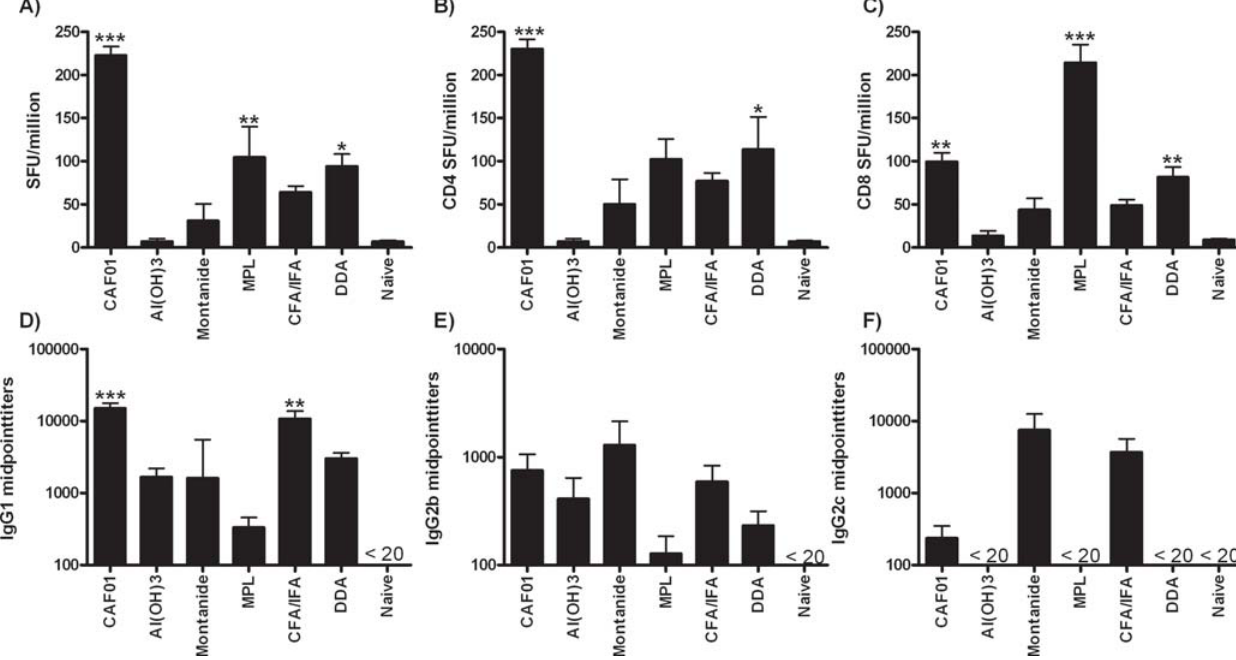
Figure 2. Comparison of CAF01 with other adjuvants. C57BL/6 mice (n=4) were immunized three times with 100 m g of OVA in CAF01, Al(OH)3, Montanide, MPL, CFA/2 6 IFA boosting with a two-week interval. A) Three weeks after the last immunization, the number of OVA-specific cells was assessed by IFN- c ELISPOT. Mean spot-forming units (SFU) upon stimulation with 5 m g of OVA per million cells 6 SEM for each group is shown. B) SFU per million cells 6 SEM upon stimulation with 5 m g of OVA CD4 T cell epitope. C) SFU per million cells 6 SEM upon stimulation with 5 m g of OVA CD4 T cell epitope. D) Sera were analysed for the presence of OVA-specific IgG1, E) IgG2b, F) IgG2c antibodies by ELISA. Mean EC50 6 SEM is shown. Values marked with an asterisk are significantly different (*, p , 0.05; **, p , 0.01, p , 0.001) compared to naı¨ve controls as assessed by ANOVA and Dunnett’s multiple comparison test.